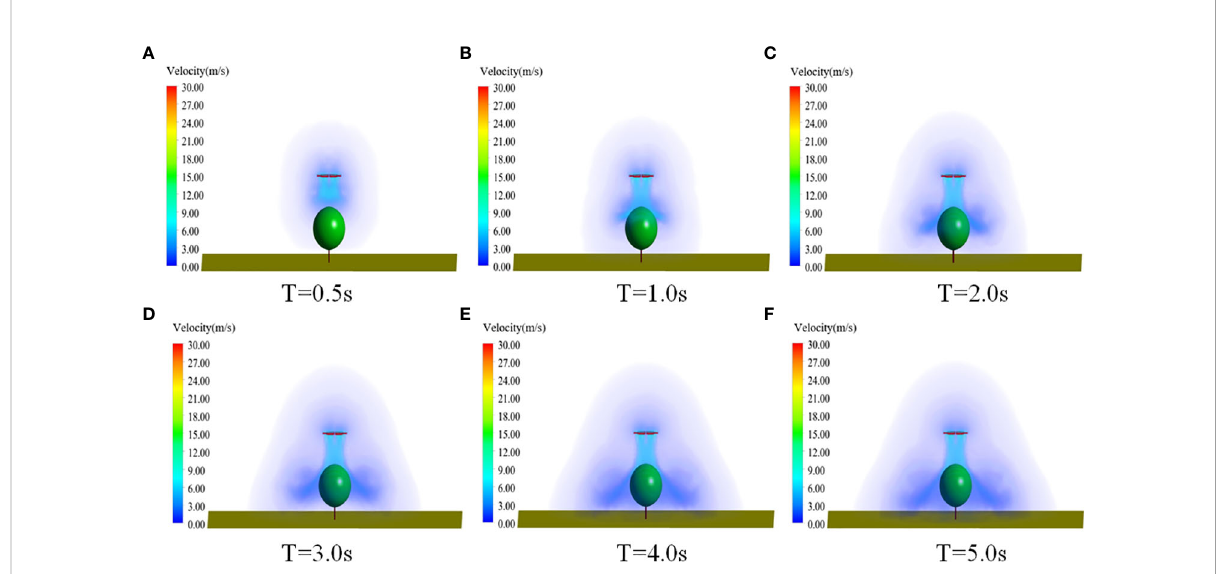
FIGURE 9 Wind fi eld speed distribution of six-rotor plant-protection UAV at different times. (A) T=0.5s. (B) T=1.0s. (C) T=2.0s. (D) T=3.0s. (E) T=4.0s. (F)